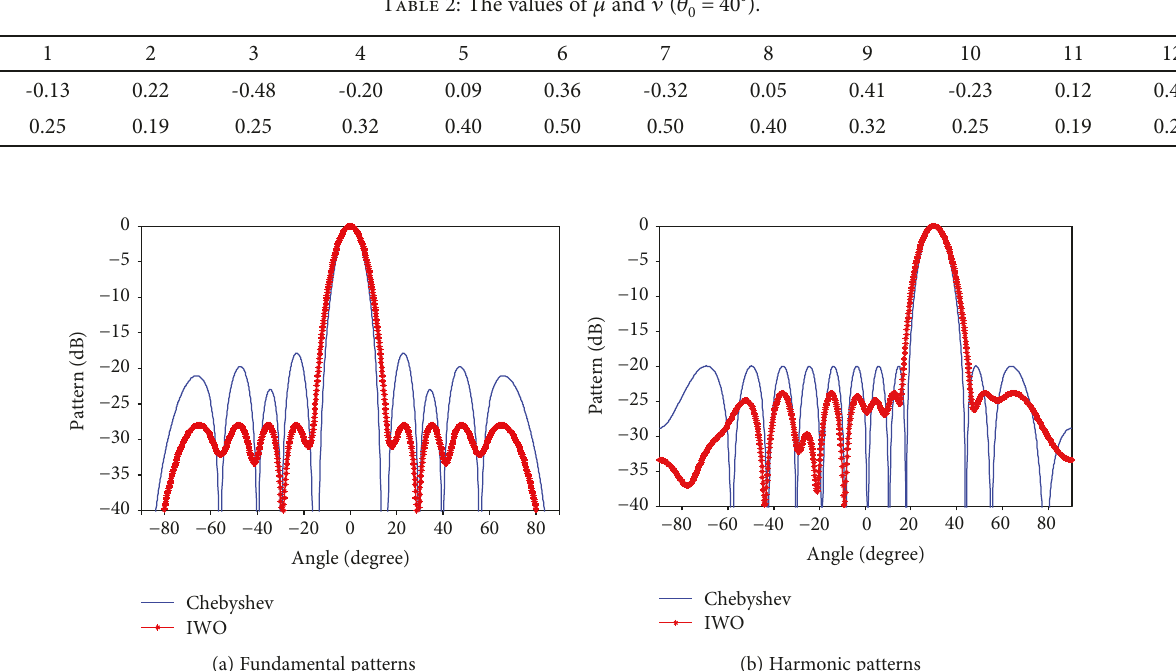
Table 1: The values of μ and ν ( θ